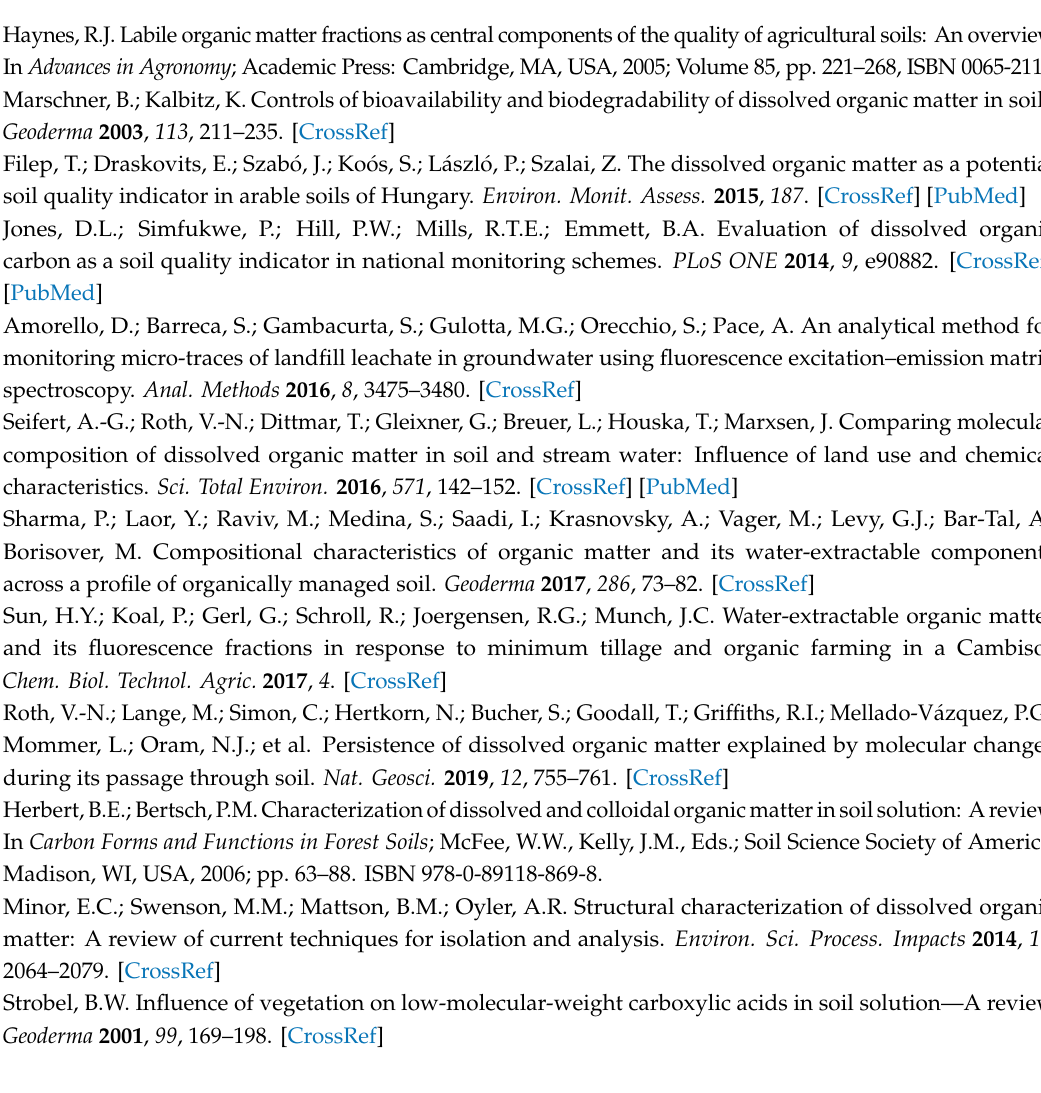
fatty esters: influence of stationary phase, time and temperature. Figure S2: (A) Mean SPME recoveries on PDMS / DVB (blue), PDMS (red) and PDMS / CAR / DVB (grey) fibers of methyl esters (10 mL, room